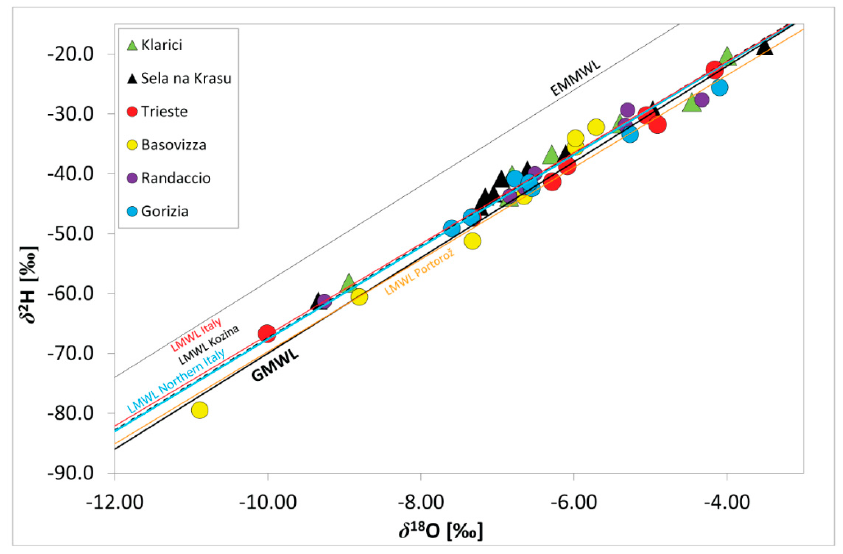
Figure 4. δ 18 O versus δ 2 H isotopic values of the precipitation samples collected in the pluviometers. Isotopic composition of δ 18 O in precipitation is predominantly more depleted (more negative) during colder months (winter) and enriched in the summer. Measured values indicate that the isotopic composition of observed precipitations falls on the Global Meteoric Water Line (GMWL) defined by Craig [67] and various Local Meteoric Water Lines (LMWLs) defined for Italy [68] and Slovenia (locations Kozina and Portorož [69,70]) and are always plotted below the Eastern Mediterranean Meteoric Water Line (EMMWL, [71]). The minimum d ‐ excess value found in the study area is 7.0‰ measured in May 2014 at Randaccio and a maximum value of 14.8‰ measured in November 2013 at Sela na Krasu (Figure 2, Table 2). Randaccio is situated practically at sea level, while the pluviometer at Sela na Krasu is sited at approximately 270 m a.s.l., so Sela na Krasu precipitation values are therefore more 18 O depleted.